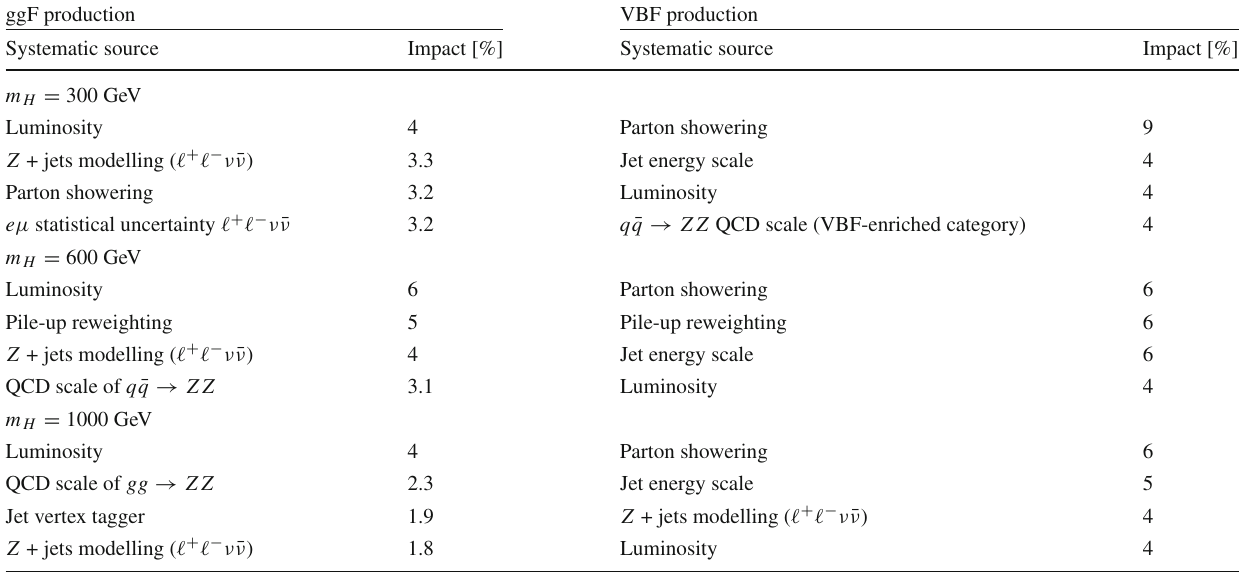
Table 3 Impact of the leading systematic uncertainties on the predicted signal event yield which is set to the expected upper limit, expressed as a percentage of the yield for the ggF (left) and VBF (right) production modes at m H = 300, 600, and 1000 GeV